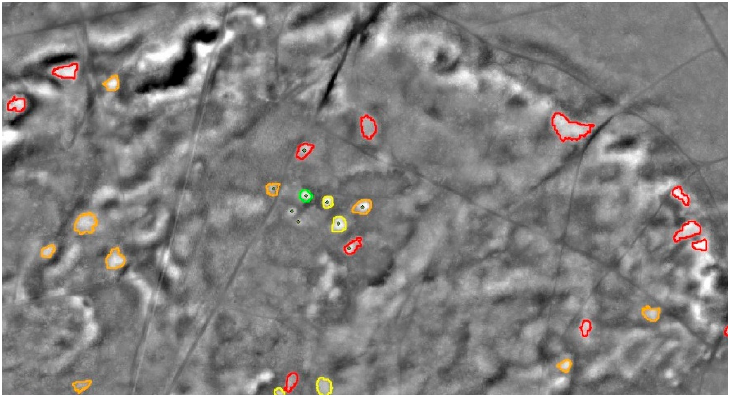
Figure 17. Classification results of Burial Mounds in Haltern. Members from the following classes are presented (Table 8); 3 (yellow), 4 (orange), and 5 (red). Mounds with a dot are included in the reference dataset [13].